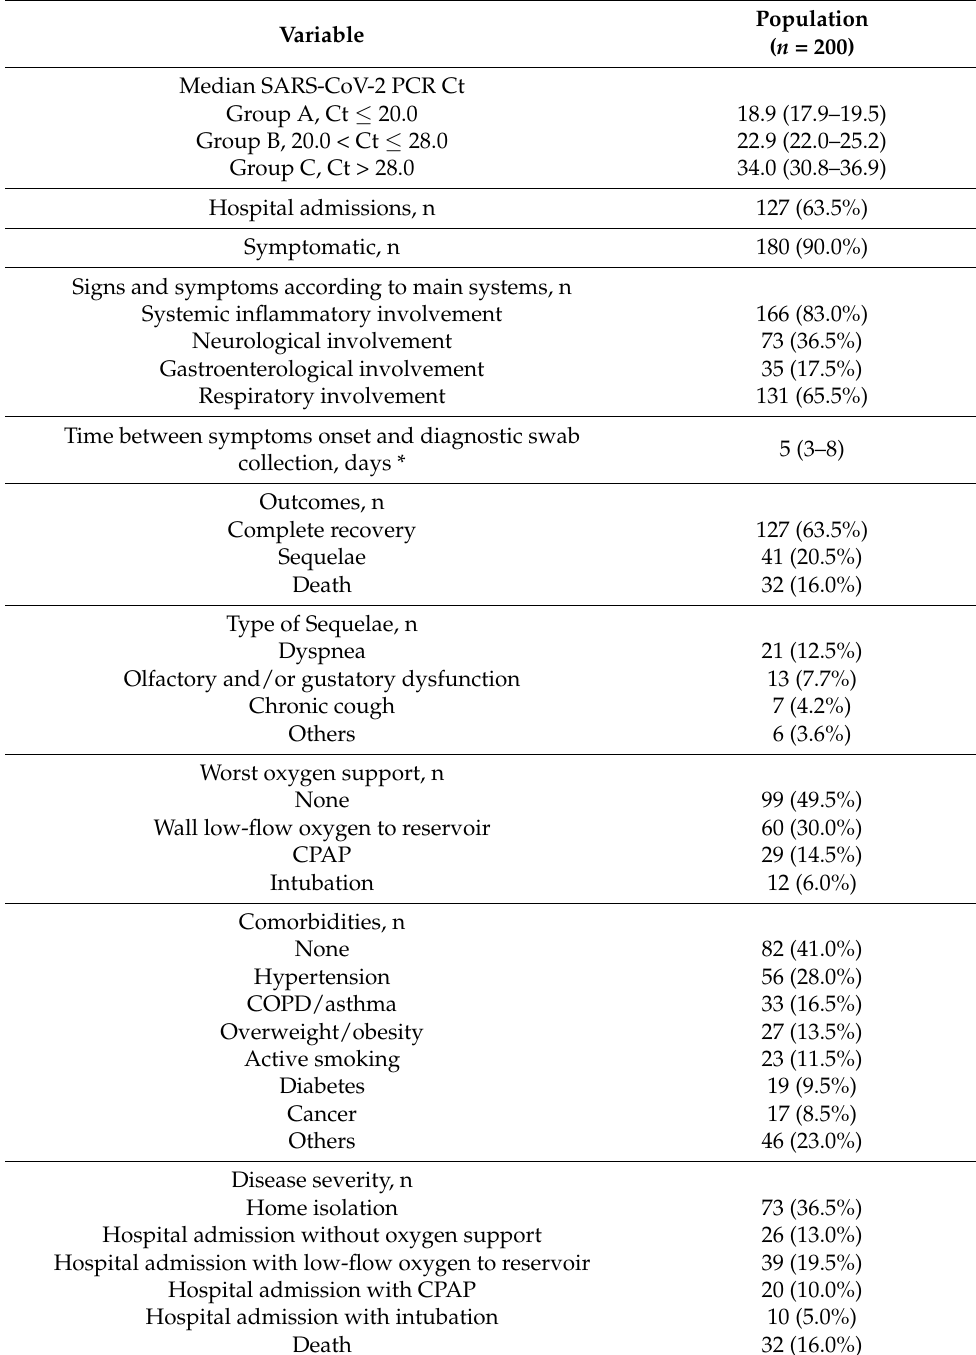
Table 1. Clinical and virological characteristics of the study